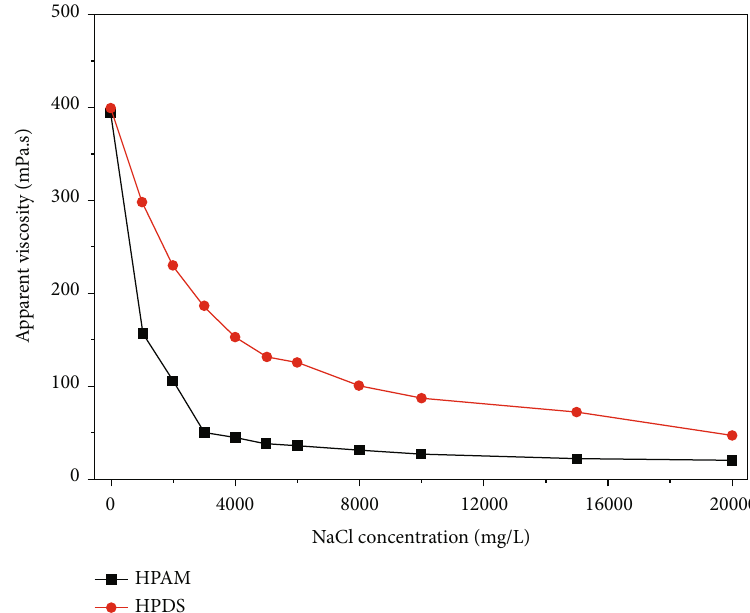
Figure 9: E ff ect of NaCl concentration on the apparent viscosity of polymer aqueous solution. The apparent viscosity was tested by Brook fi eld DV-III rheometer at 7.34 s − 1 .